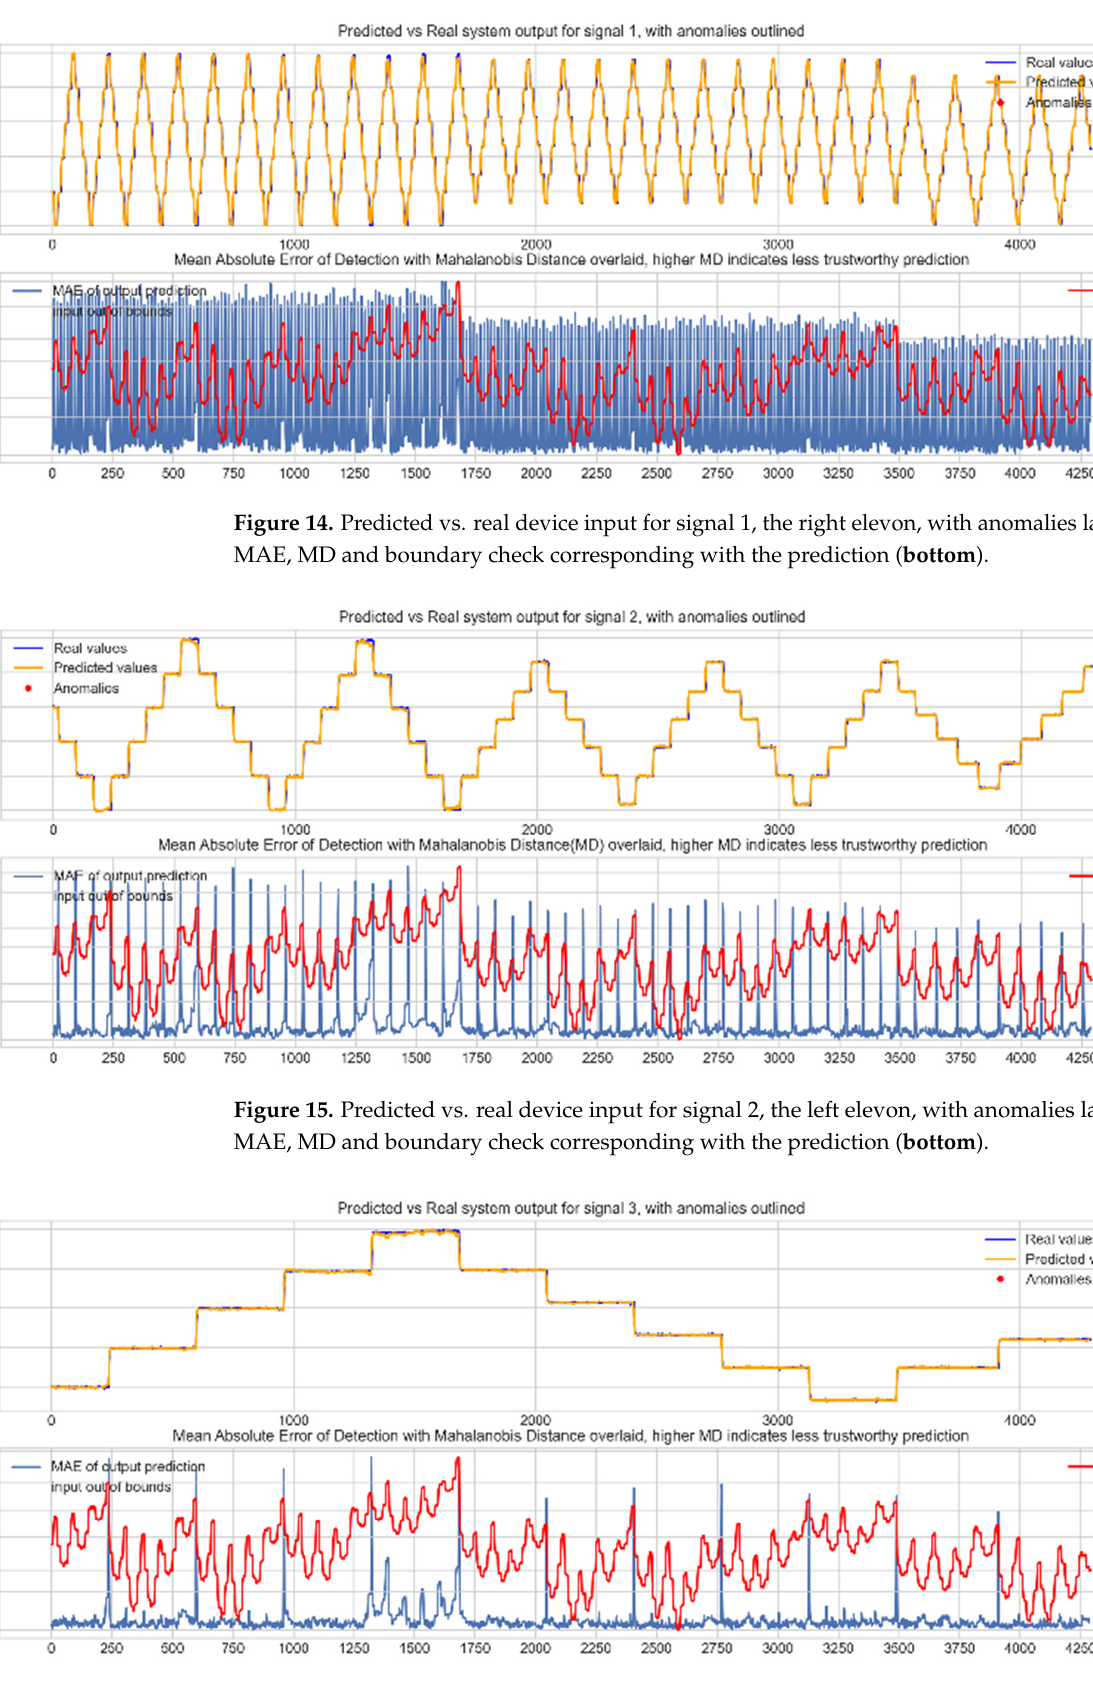
Figure 16. Predicted vs. real device input for signal 3, the motor power, with anomalies labelled ( top ); MAE, MD and boundary check corresponding with the prediction ( bottom ).